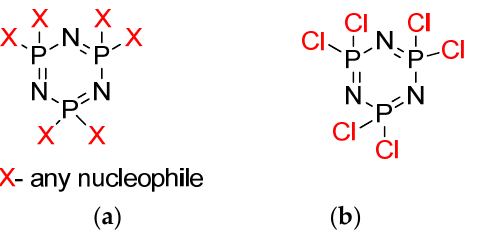
Figure 1. Chemical structure of ( a ) cycloytriphosphazene and ( b ) HCCP. Dogan et al. also reported that cyclotriphosphazene derivatives containing a bis-aryl Schiff base having a different terminal group (H, F, Cl, and Br) have good thermal properties, which makes them suitable as a flame retardant additive to slow down the spread of the flame ignition or slow down the spread of flame after ignition of materials [15].